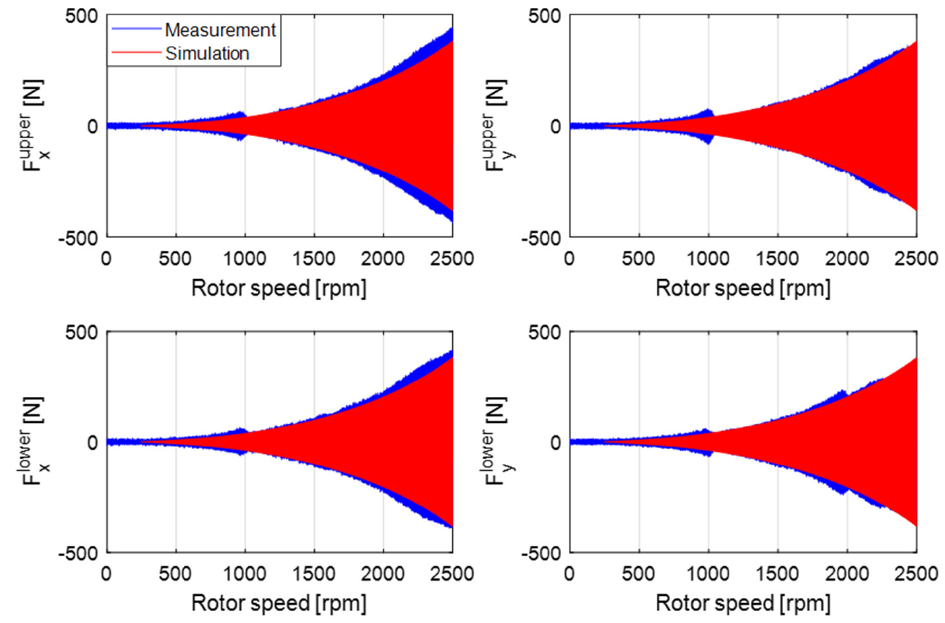
Figure 18. The simulated and measured bearing forces with 5.9 × 10 − 3 kg · m unbalance magnitude and 2 π rad/s 2 angular acceleration.